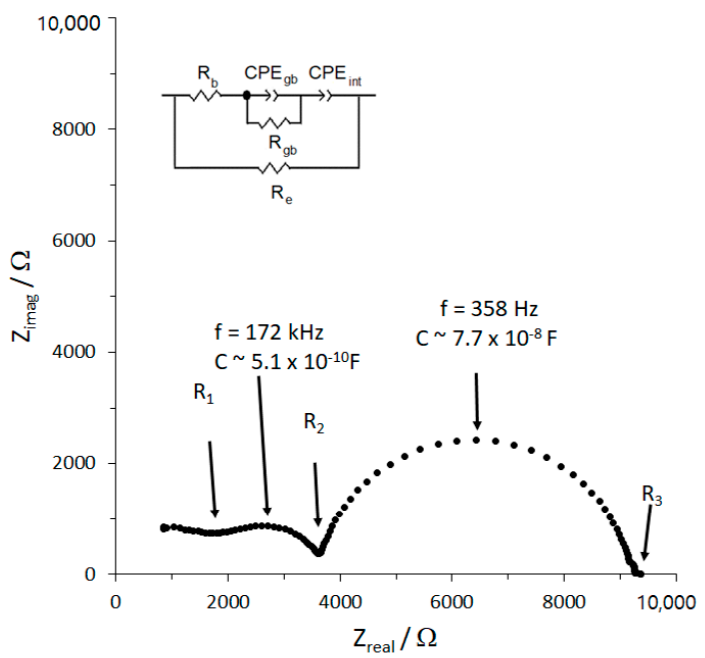
Figure 5. Room temperature impedance plot of hot-pressed Li 1.25 Cr 0.25 Ti 1.5 O 4 /3% LBO and the equivalent circuit used to interpret the data where R 1 = R e R b /(R e + R b ), R 2 =R e (R b + R gb )/(R e + R b + R gb ), and R 3 =R e